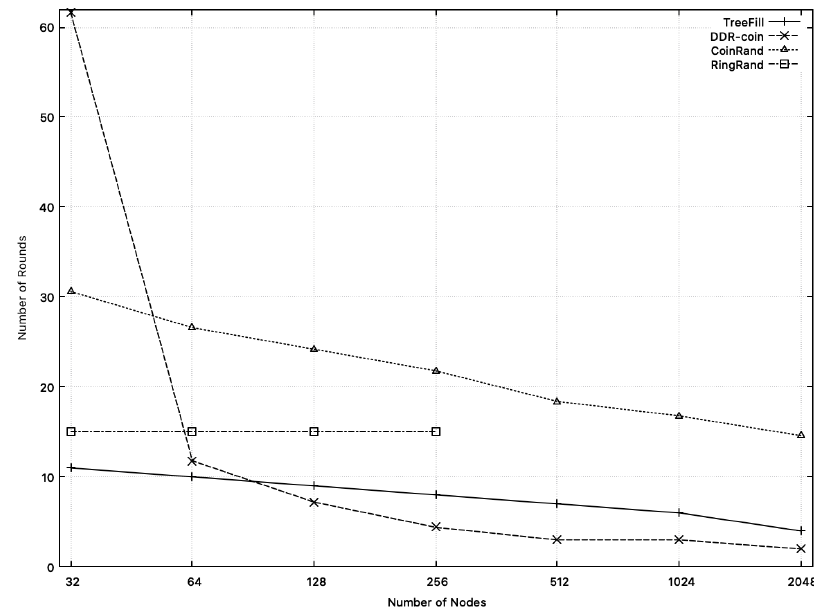
Figure 13. Comparison of the numbers of rounds of DDR-coin, TreeFill, CoinRand, and RingRand when the number of nodes are 2 i where 5 ≤ i ≤ 8. The number of triggers is w =